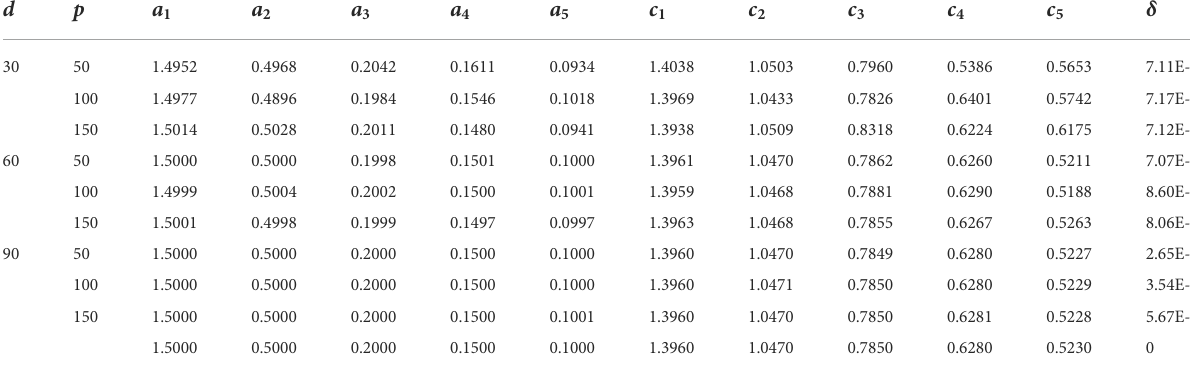
TABLE 2 Results of parameter estimates of Example 1 for G = 1,000.